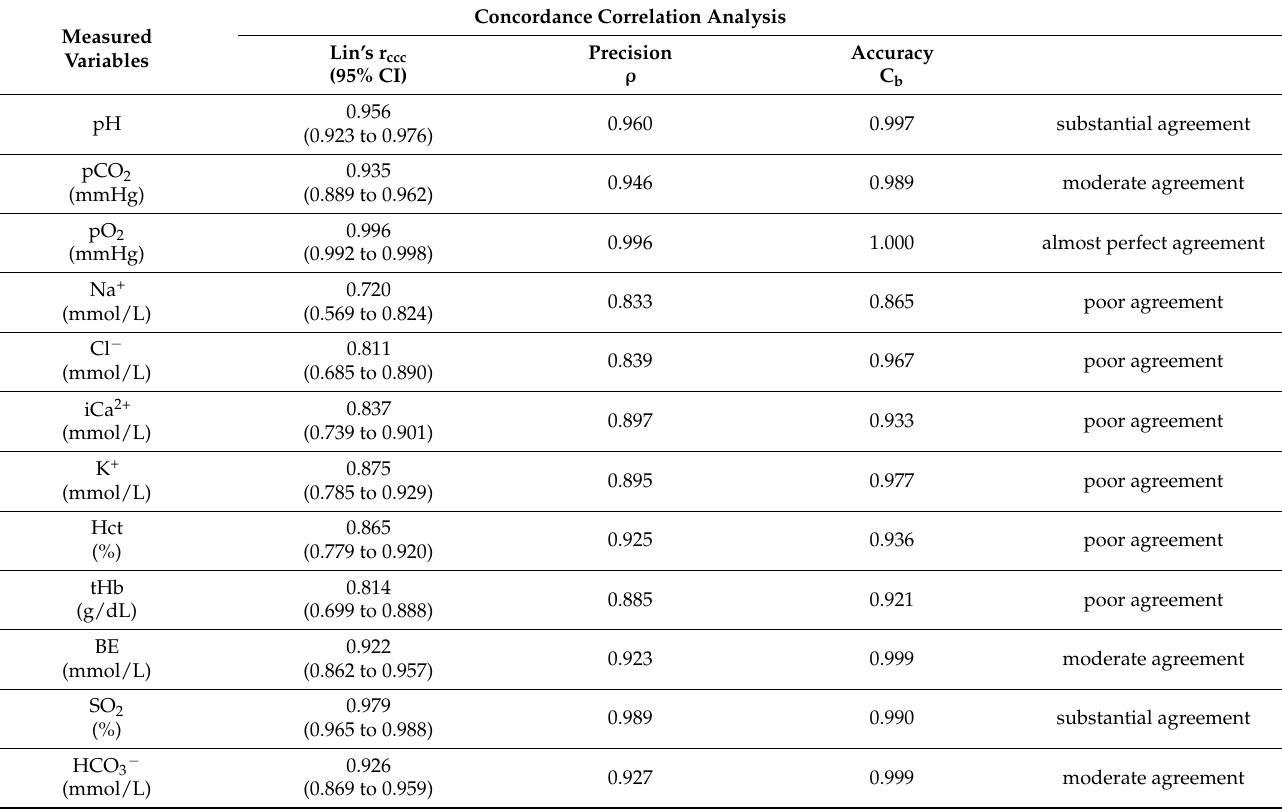
Table 3. Concordance correlation analysis between the epoc and the GEM5000 analyzer, indicating the accuracy (bias correction factor, C b ) and the precision (Pearson ρ ) as well as the Lin’s concordance correlation coefficients (r ccc ) with 95% confidence intervals (95%